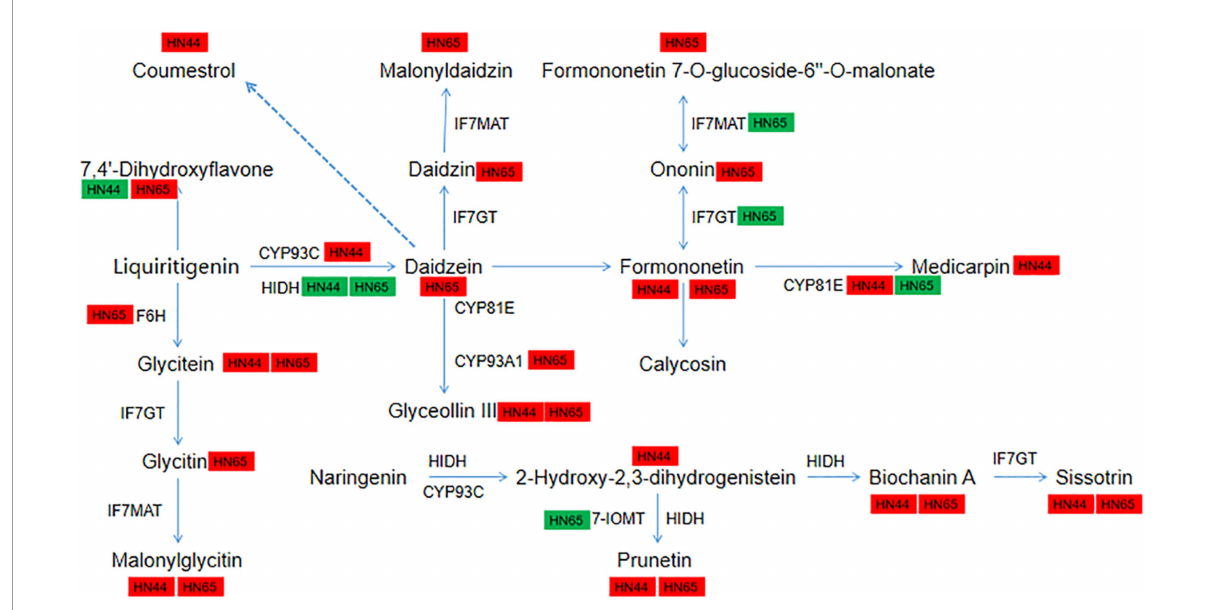
FIGURE11 Pathway diagram of isoflavone synthesis. In this figure, red indicates up-regulation of genes/metabolites, and green indicates down-regulation of genes/metabolites.